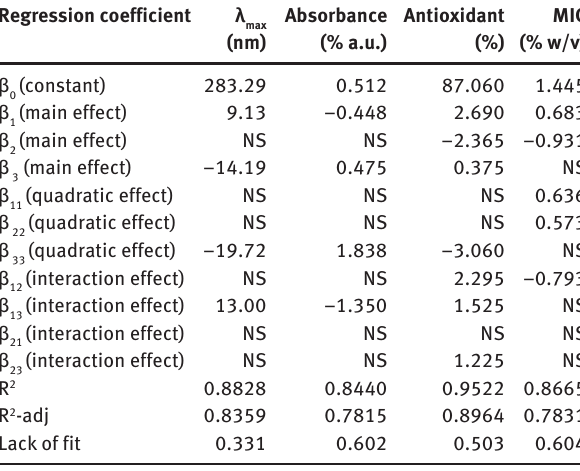
Table 2: Regression coefficients, R 2 , adjusted R 2 (R 2 -adj) and probability values for the final reduced